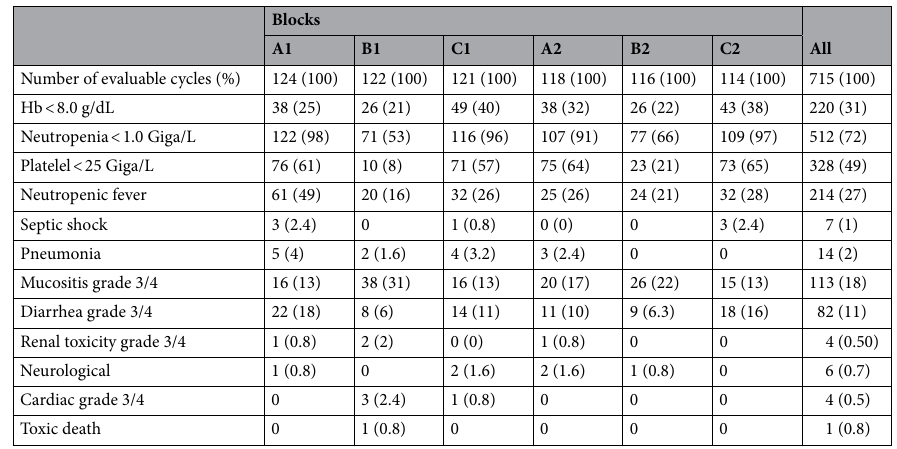
Table 3. Summary of grade 3–4 toxicity of